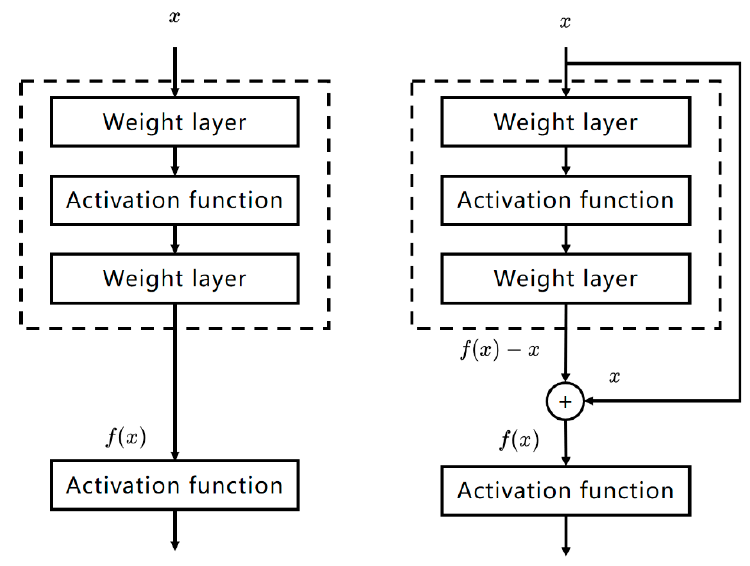
Figure 1. Normal block ( left ) and residual block ( right